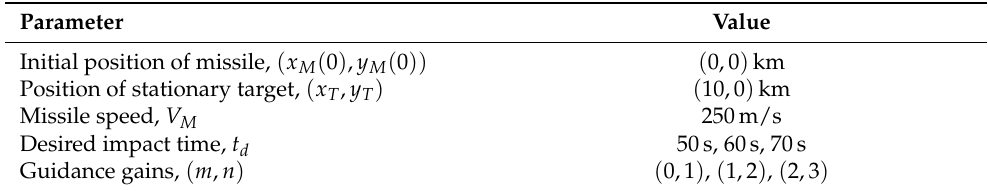
Table 1. Simulation